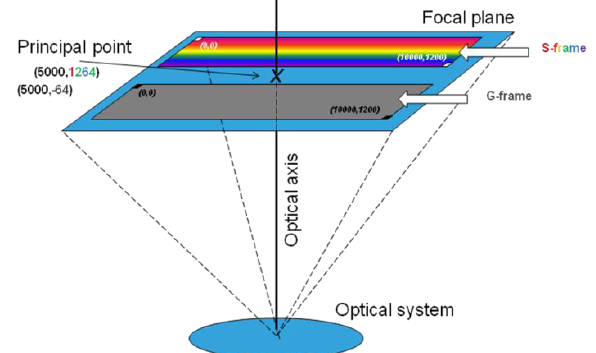
Figure 3 layout of the focal plane of an example of a geospectral camera